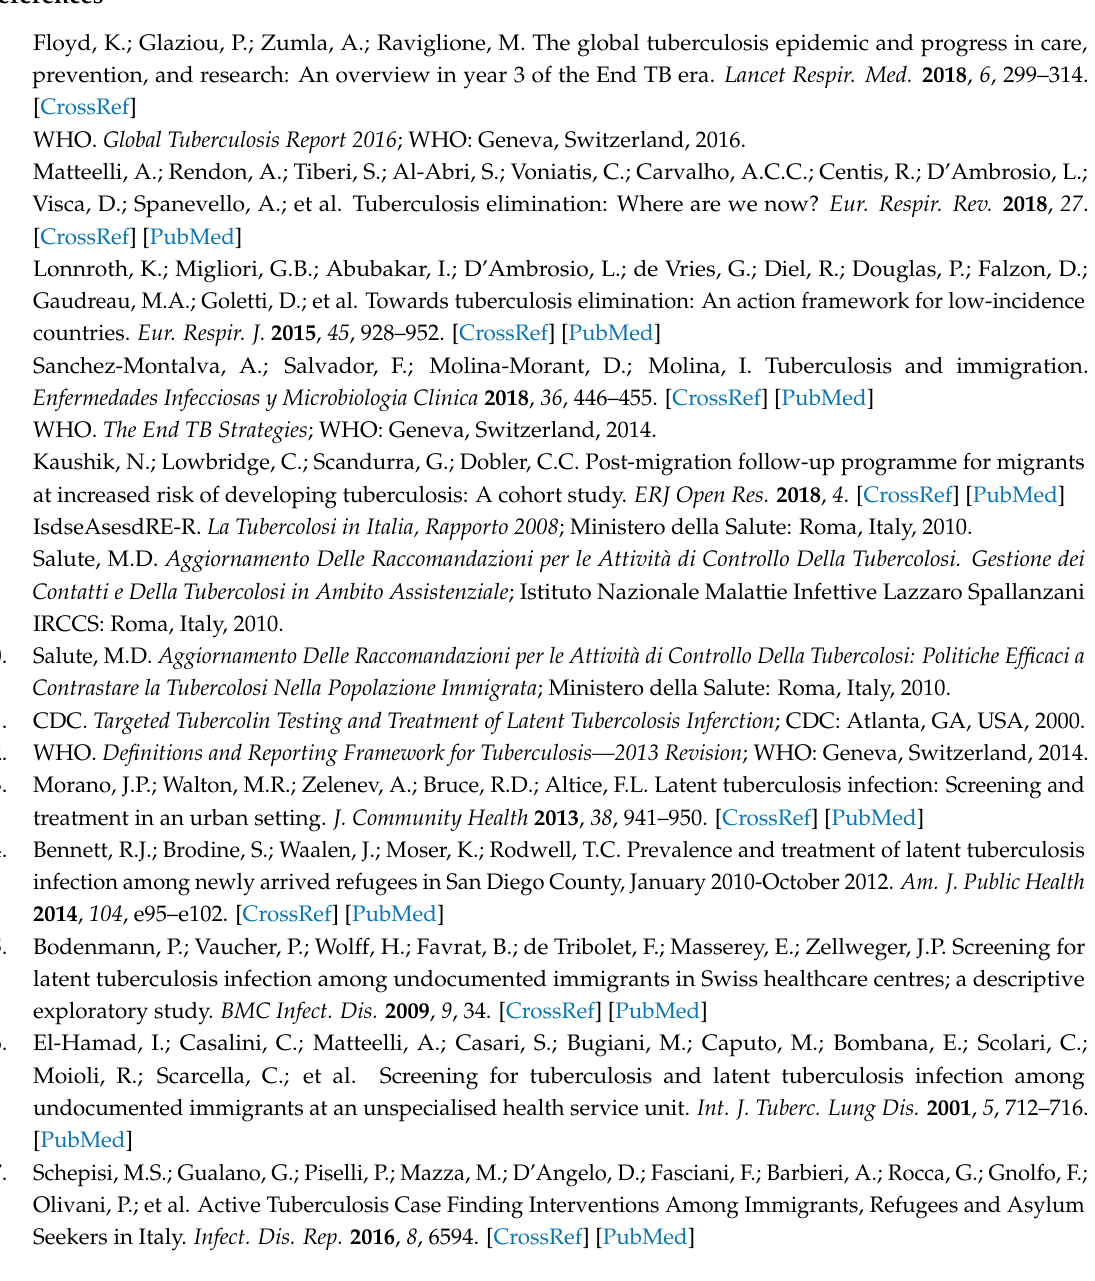
Table S5: Association between selected characteristics and compliance with Quantiferon-TB gold (QFT) execution (bivariate and multivariate analysis). Table S6: Association between selected characteristics and outcome of Latent Tuberculosis Infection (LTBI) treatment (bivariate